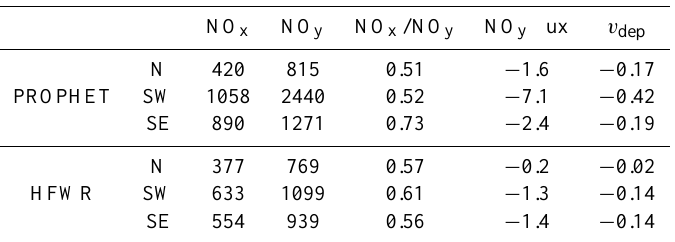
Fig. 10. Diurnal plot of NO (red crosses) and NO 2 (green open circles) fluxes observed at (a) PROPHET and (b) HFWR. Solid lines indicate hourly median. Table 2. Median observed quantities as a function of wind direction. NO x and NO y mixing ratios inppt, fluxes inpptms − 1 , and v dep incms − 1